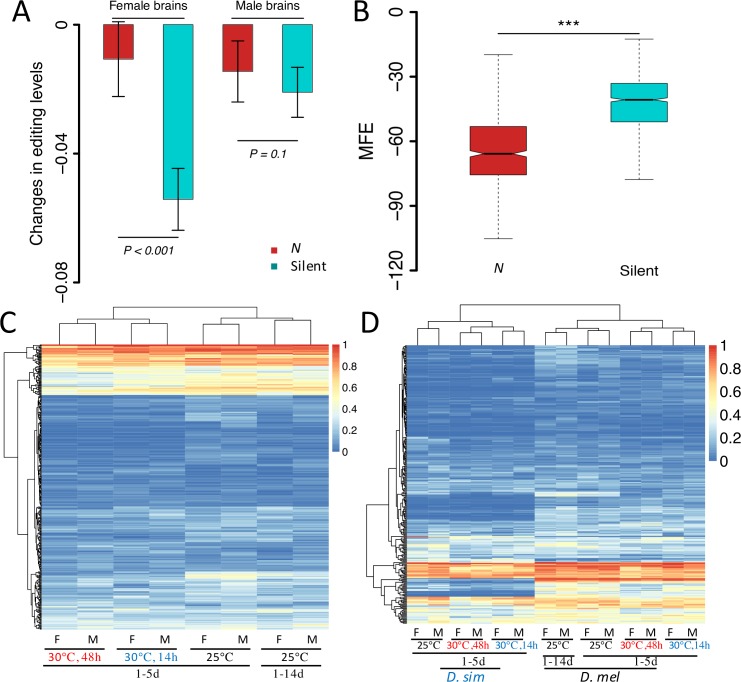
The effect of temperature on editing levels in brains of Drosophila.(A) The changes of editing levels in N and silent (S and UTRs) sites in female and male brains under elevated temperature (stressed at 30°C for 48 hours). (Error bar represents the s.e. of the level changes for editing sites in each category). (B) The flanking sequences (100 nts at each side) have significantly lower MFE (Kcal/mol) for the N sites compared to the silent sites. (C) Clustering the brain libraries of D. melanogaster based on the editing levels of 391 high-confidence editing sites that have at least 20 raw reads in each brain library. Note flies of the same accommodation conditions always cluster together. (D) Clustering the brain libraries of D. melanogaster and D. simulans based on the editing levels of 289 high-confidence editing sites that have at least 20 raw reads in each brain library. Note species divergence plays a more important role than temperature in clustering the samples.